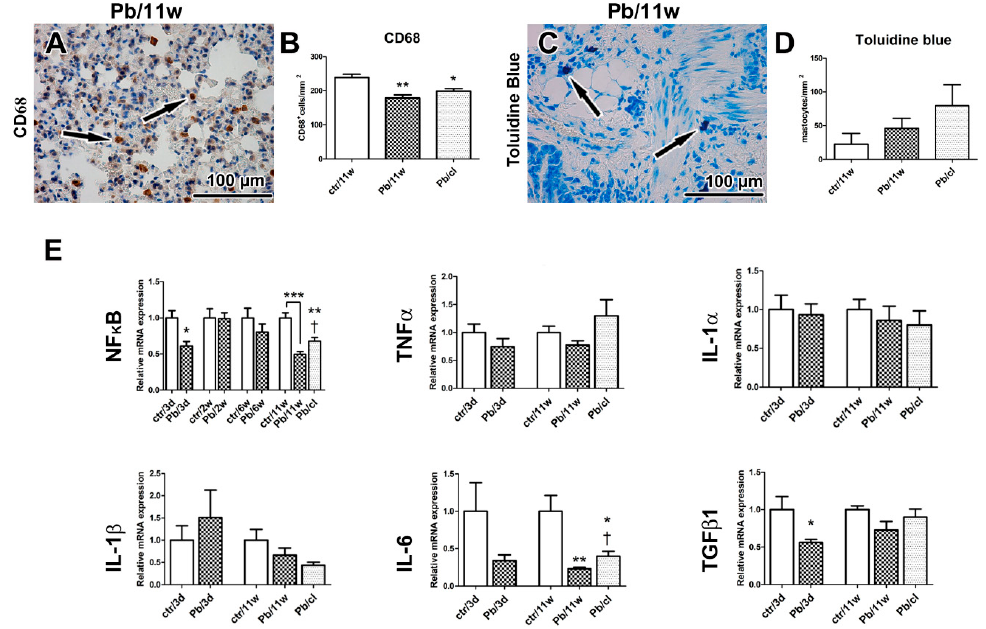
Figure 3. The e ff ect of Pb(NO 3 ) 2 NP inhalation and its clearance on the lung inflammation. ( A ) Detection of CD68-positive cells (marker of macrophages) in lungs (arrows). ( B ) The number of